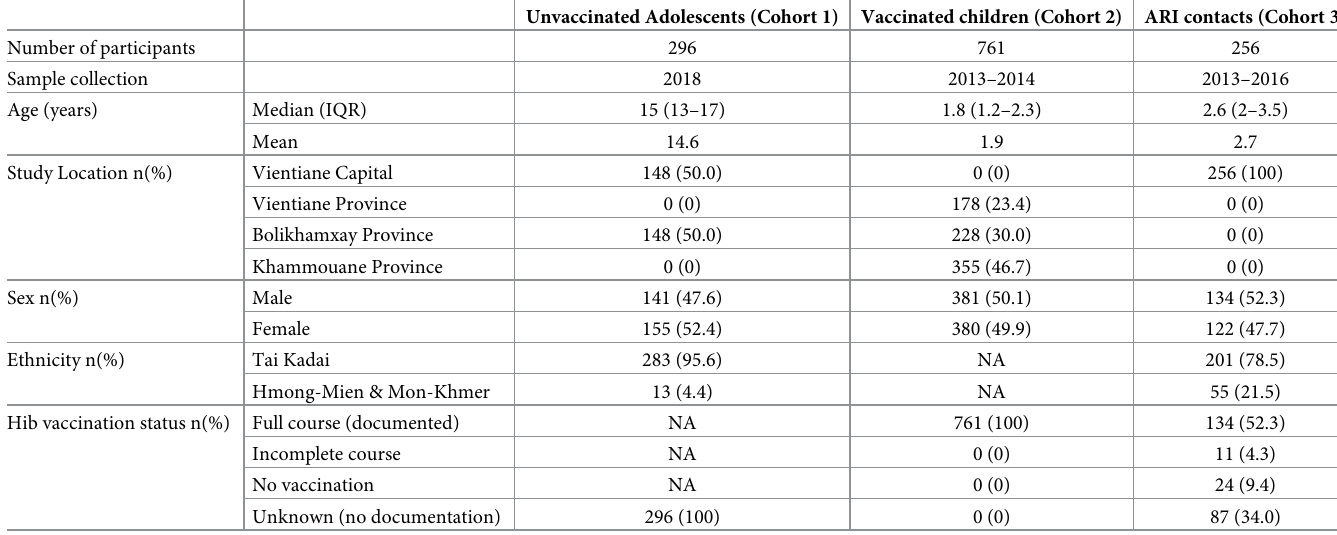
Table 1. Characteristics of study participants by